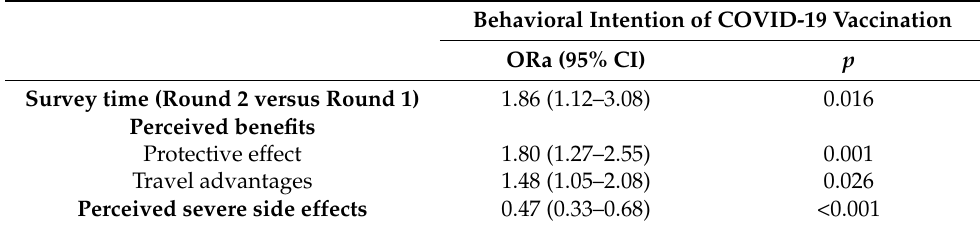
Table 3. Factors of behavioral intention for COVID-19 vaccination (pooled sample: n =